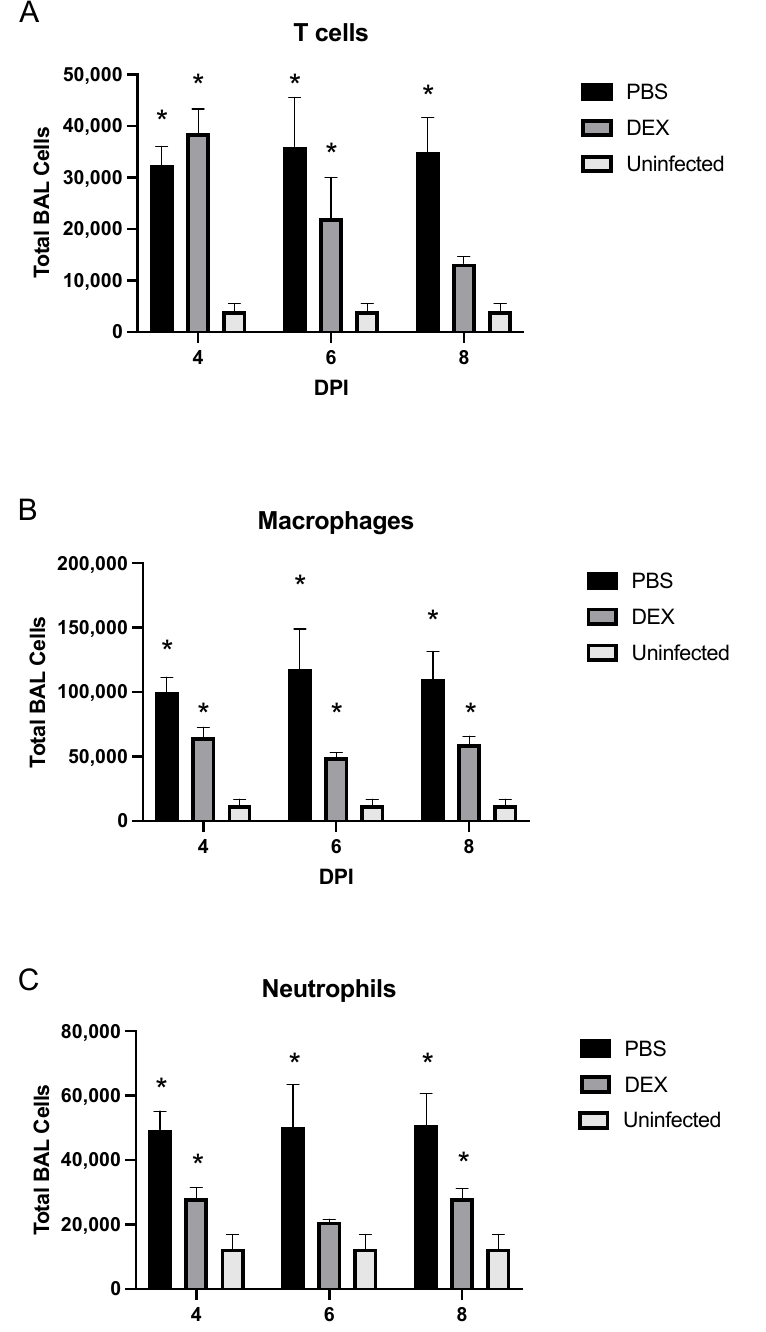
Figure 4. BAL cell phenotypes during IBV infection. BAL cell phenotypes from mice treated with PBS (black bars) or 10 mg/kg DEX (gray bars) and uninfected, untreated mice (white bars) were stained for ( A ) CD3 + T cells, ( B ) CD3 − /CD11b + /Ly6G − macrophages, and ( C ) CD3 − /CD11b − /Ly6G + neutrophils, as determined by flow cytometry. Bars represent the mean +/ − SEM of total BAL leukocytes on days 4, 6, and 8 pi (DPI). * p < 0.05 by two-way analysis of variance (ANOVA) with Bonferroni’s correction compared with uninfected, untreated mice. (n = 3–5 mice/group/time point). On day 8 pi, the CTL to Th ratio in the BAL was 2:1 (Figure 5A), a finding similar to that found in a recent study of IAV-infected mice [37], and there were significantly ( p < 0.05) more CTLs in PBS-treated mice than in DEX-treated mice. To determine the BAL T cell functionality, BAL cells collected on day 8 pi were nonspecifically stimulated